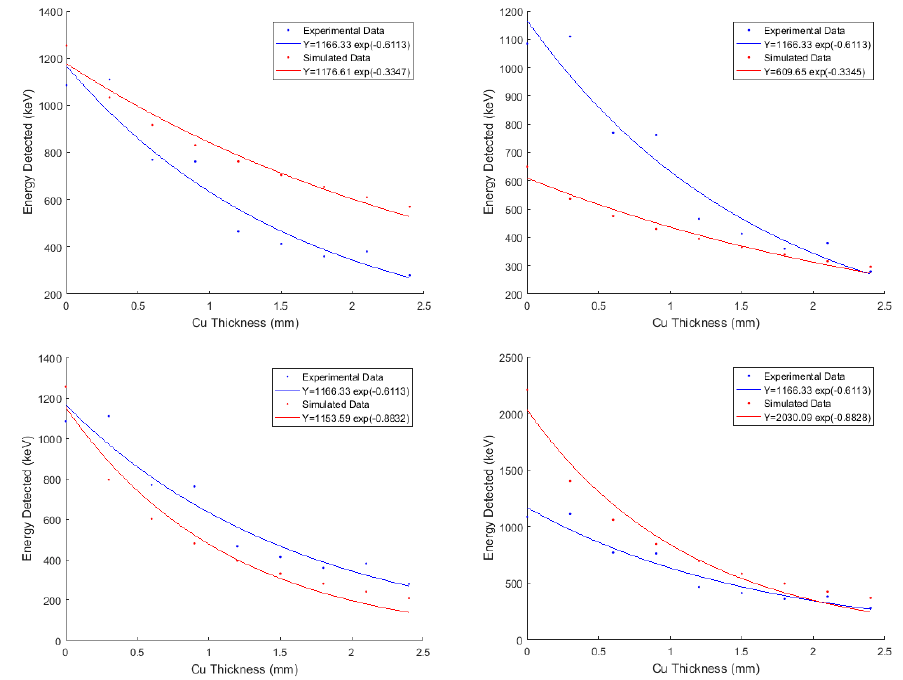
Figure 7. Sensitivity of the simulated results to the parameters. The two upper plots are plotted with E max = 350 keV which is higher than the optimal, and k [ Kram ] = 0.00415 in the upper left and k [ Kram ] = 0.00215 in upper right plot. No value of k [ Kram ] could be found to match the experimental and simulated result. Similarly, with E max = 150 keV, which is lower than optimal is chosen in the bottom plots where k [ Kram ] = 0.0316 in the bottom left and k [ Kram ] = 0.0556 in bottom right plot. No value of k [ Kram ] could be found to match the experimental and simulated result.